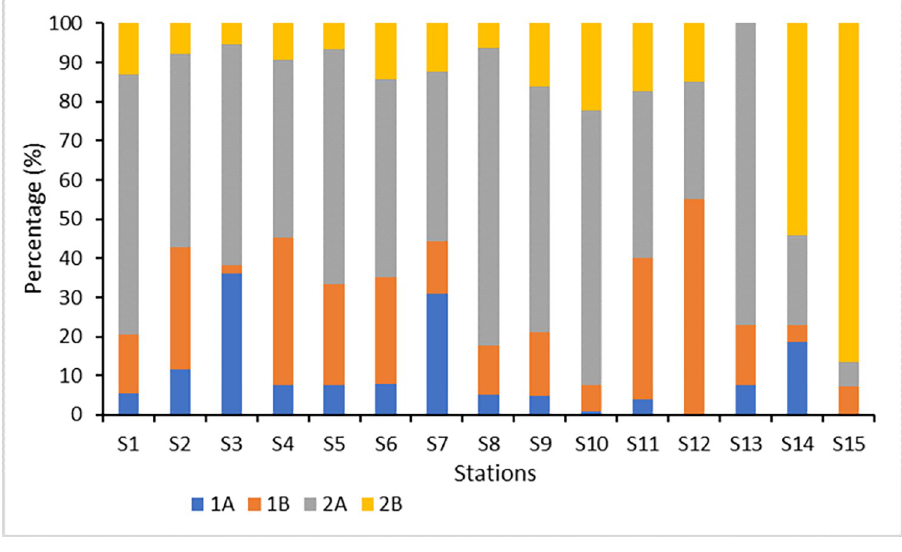
Fig 3. Percentage of Functional Feeding Group (FFG) of marine nematodes in the conservation area (Chaojing Park) and its adjacent area of Keelung,